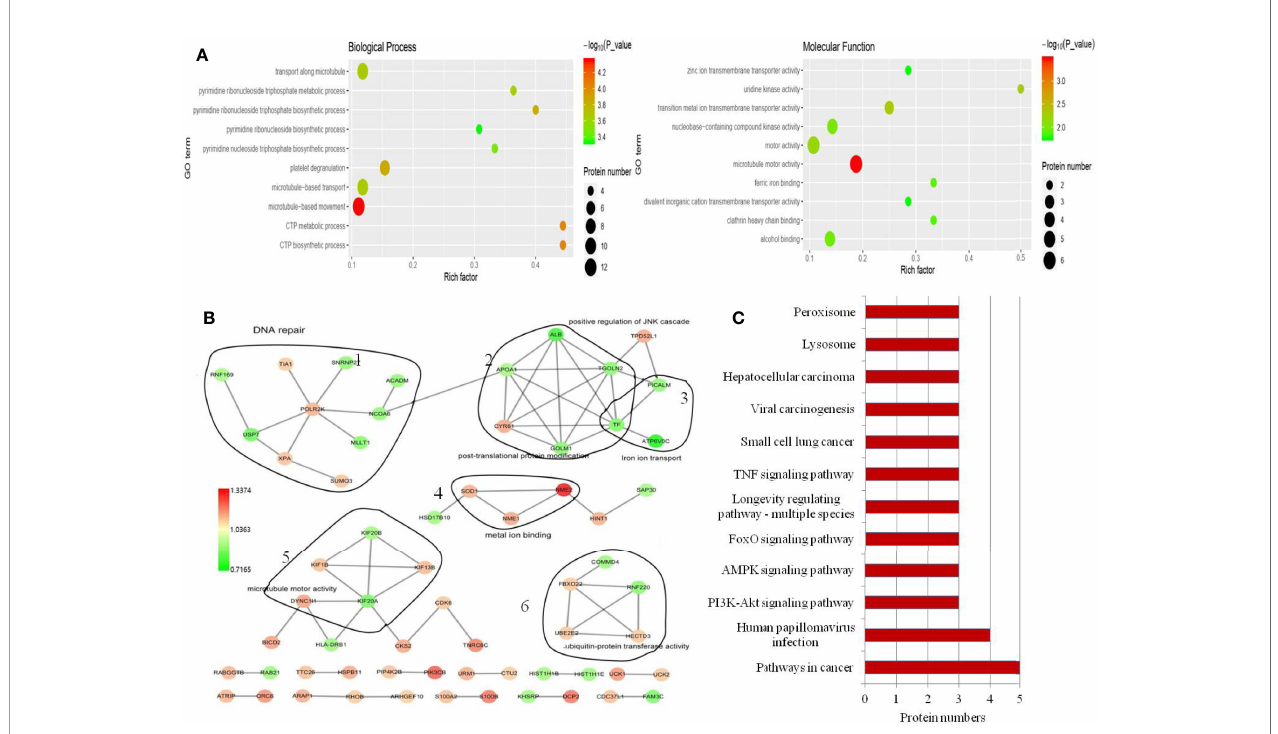
FIGURE 3 | GO annotation and KEGG pathway analysis of the DEPs. (A) Top 10 enriched GO terms under “ biological process ” . Term01, microtubule-based movement; term02, CTP metabolic process; term03, CTP biosynthetic process; term04, platelet degranulation; term05, pyrimidine ribonucleoside triphosphate biosynthetic process; term06, microtubule-based transport; term07, transport along microtubule; term08, pyrimidine ribonucleoside triphosphate metabolic process; term09, pyrimidine nucleoside triphosphate biosynthetic process; term10, pyrimidine ribonucleoside biosynthetic process. Top 10 enriched GO terms under “ molecular function ” . Term01, microtubule motor activity; term02, transition metal ion transmembrane transporter activity; term03, uridine kinase activity; term04, motor activity; term05, nucleobase-containing compound kinase activity; term06, alcohol binding; term07, clathrin heavy chain binding; term08, ferric iron binding; term09, zinc ion transmembrane transporter activity; term10, divalent inorganic cation transmembrane transporter activity. (B) Protein – protein interaction network generated with STRING and visualized with Cytoscape for DEPs. DEPs are represented as round nodes. The red node indicates upregulation and green node indicates downregulation of the DEPs. Corresponding to proteins related to DNA repair (1), post-translational protein modi fi cation and iron ion transport (2), microtubule motor activity (3), metal ion binding (4) and ubiquitin-protein transferase activity (5), ubiquitin-protein transferase activity (6). (C) Enriched KEGG